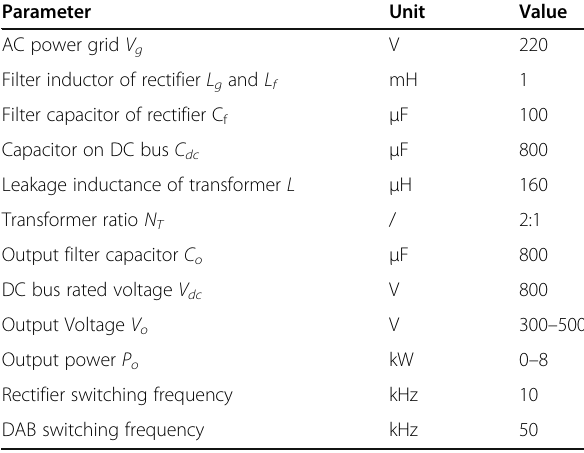
Table 1 Real-time simulation